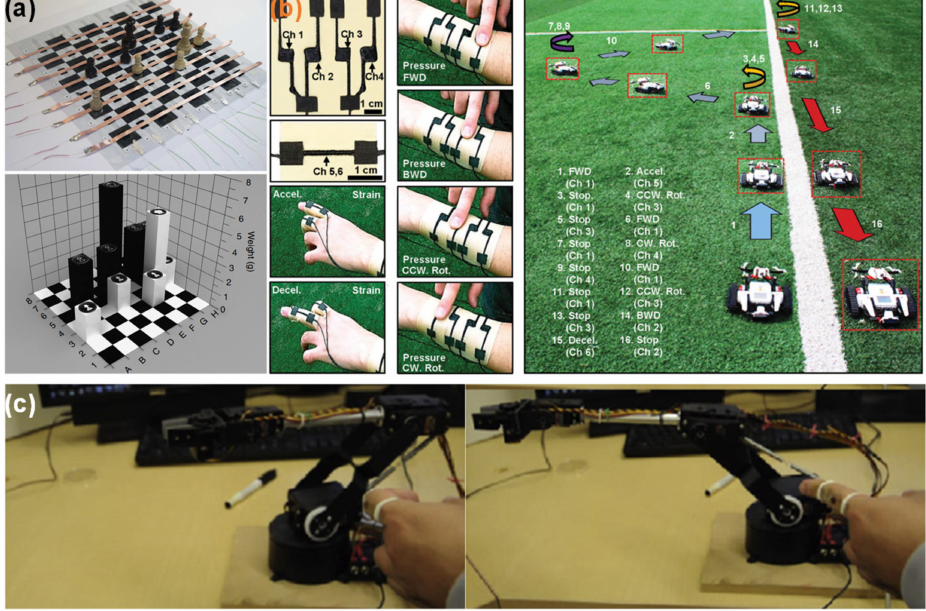
Figure 18. E-skins applied in HMI. ( a ) E-skin array developed by Zhenan Bao and co-workers in 2014 for the detection of chess pieces on a chess board (left), with the respective map reconstruction of the pieces position according to weight (right) [41] (Copyright © 2020, Springer Nature). ( b ) E-skin developed by Dae-Hyeong Kim and co-workers in 2014 for the control of a tank like robot (right), with the identification of the command associated to each pressure or strain sensor (left) [42]